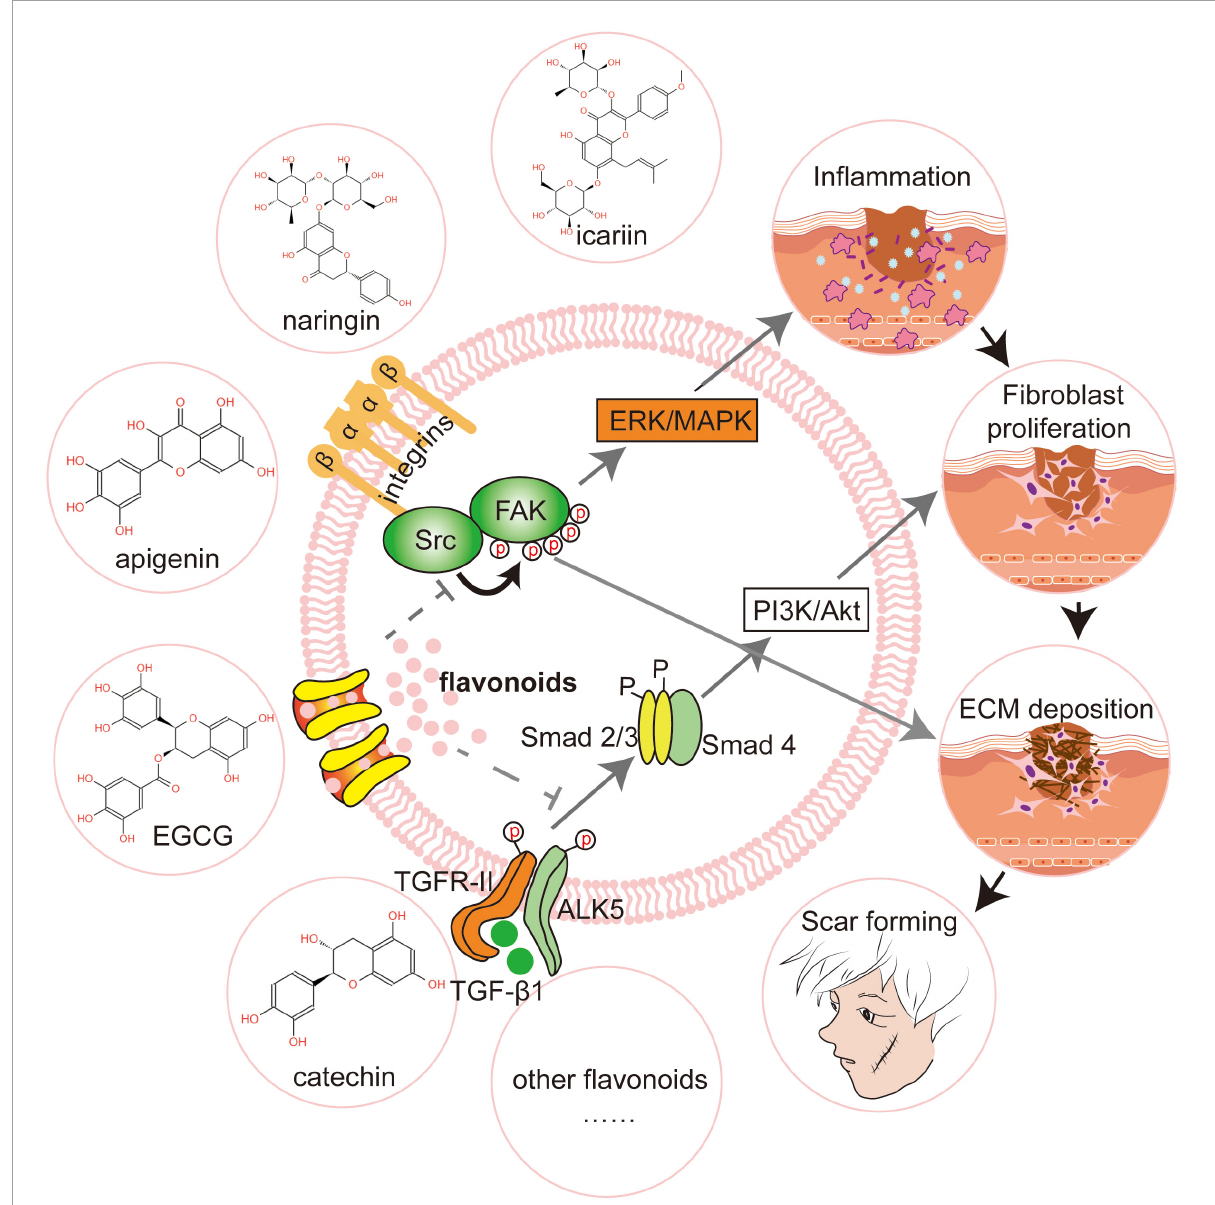
FIGURE2 Flavonoids promote scar-free regeneration by regulating signaling pathways. Flavonoids like icariin and epigallocatechin gallate (EGCG) limit fibroblast proliferation and motility by modifying transforming growth factor-1 (TGF-1) and so suppressing the PI3K/AKT signaling pathway. Apigenin drastically lowers focal adhesion kinase (FAK) activity and, as a result, changes the phosphorylation of extracellular signal-regulated kinase (Erk1/2). Catechin, by binding to Scr, reduces extracellular matrix deposition and enhances scar-free wound healing. FAK, Focal Adhesion Kinase; Src, Sarcoma gene; Erk, Extracellular regulatxory protein kinase; MAPK, Mitogen-activated Protein Kinase; Alk5, Activin receptor-like kinase 5; PI3K, Phosphatidylinositol 3-kinase; Akt, Protein kinase